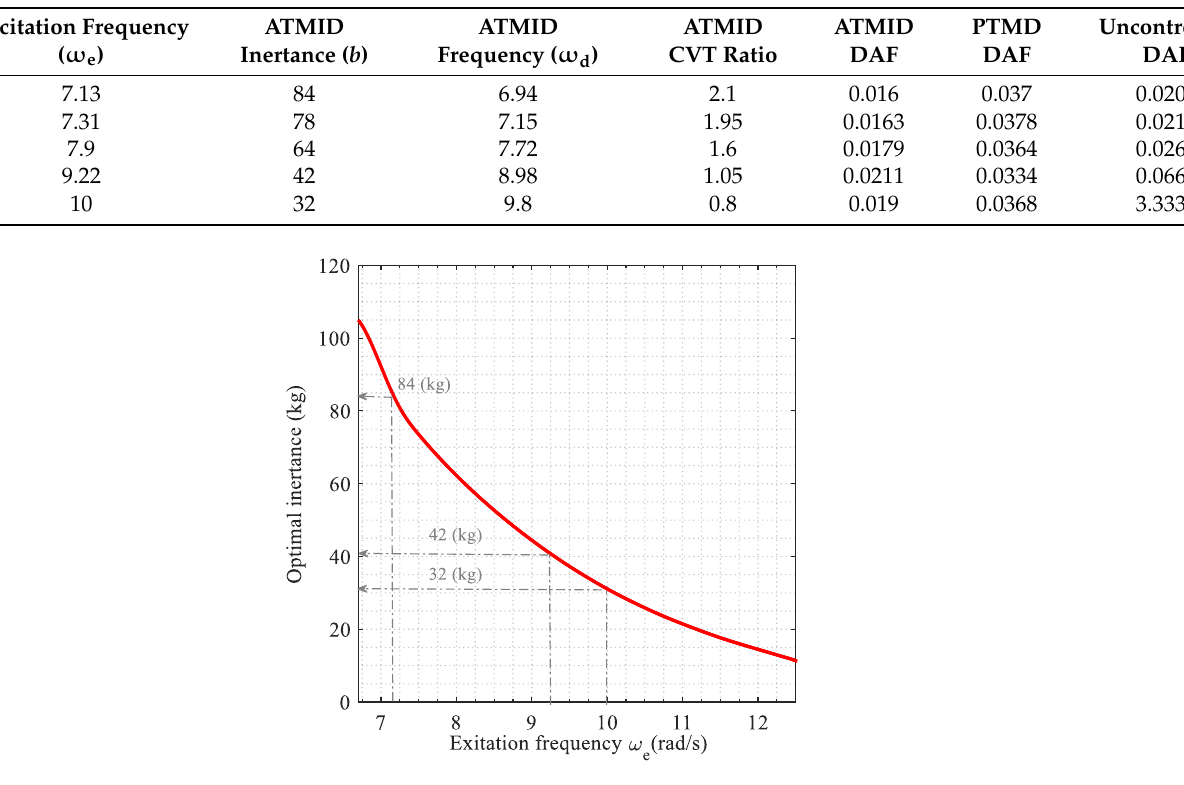
Figure 8. Required optimal inertance of ATMID in each excitation frequency.